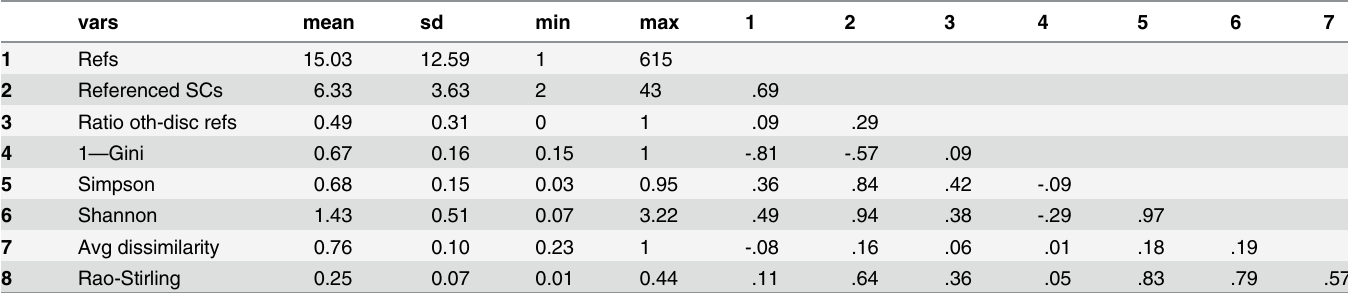
Table 2. Descriptive Statistics and Spearman Correlations ( N =